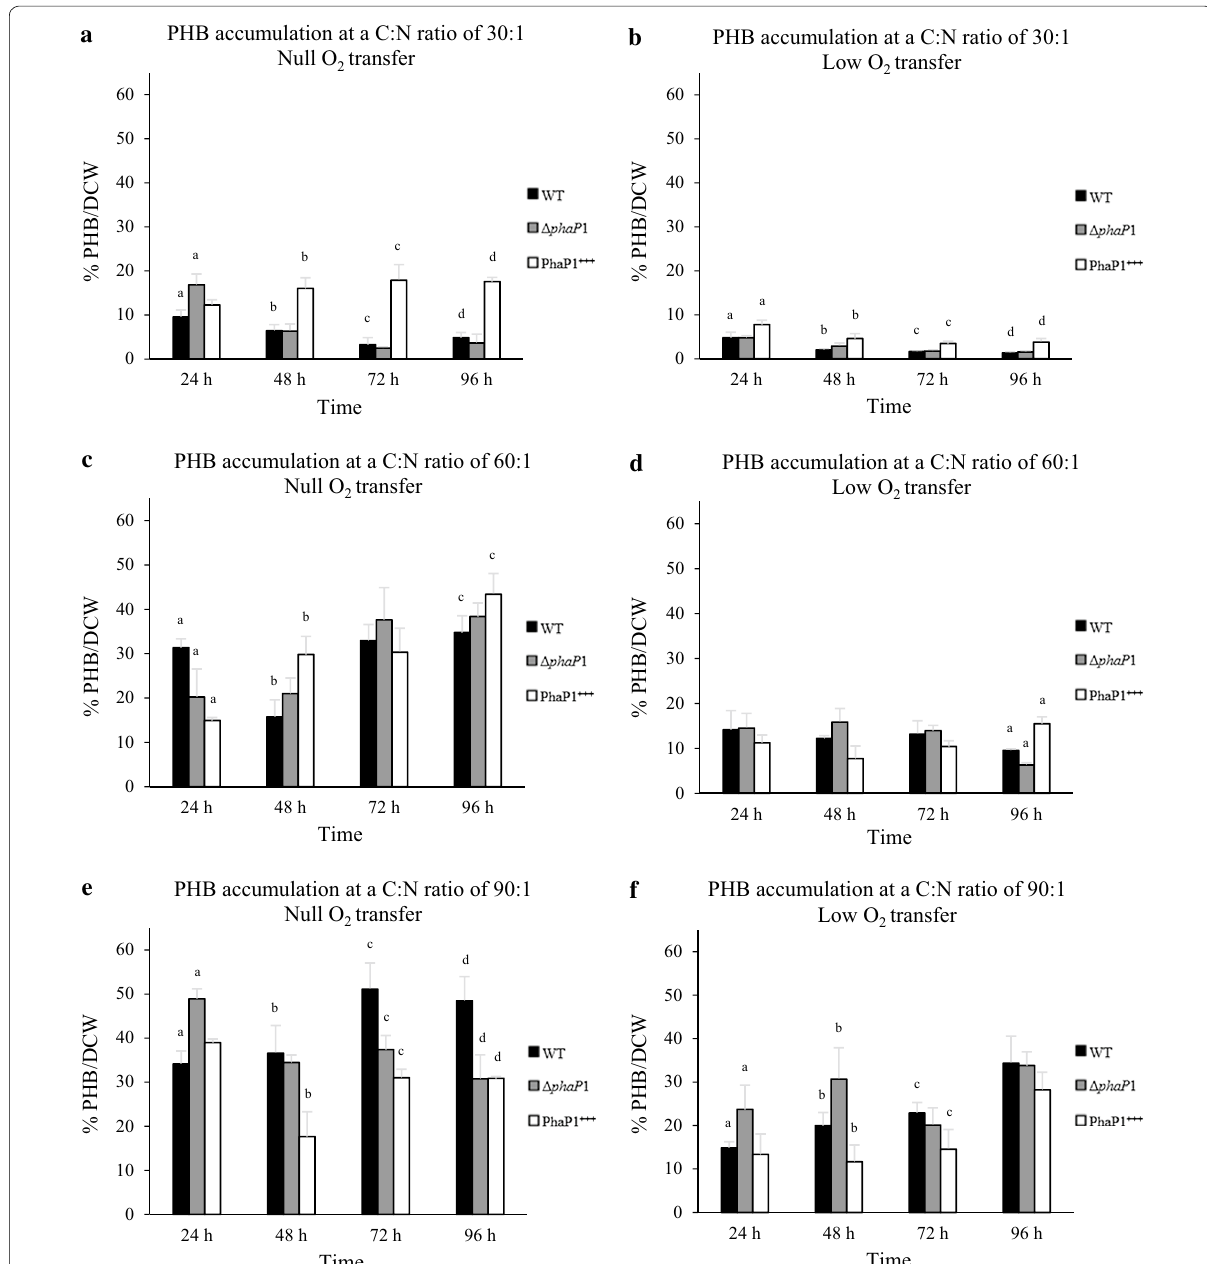
Fig. 5 PHB/DCW content in A. brasilense strains. For PHB quantitation, flasks containing minimal medium supplemented with malic acid and ammonium chloride at C:N ratios of 30:1 ( a and b ), 60:1 ( c and d ), and 90:1 ( e and f ) were inoculated with the A. brasilense strains in flasks subjected to null ( a , c and e ) or low ( b , d and f ) oxygen transfer. Samples of cultures of A. brasilense were taken every 24 h for 96 h. Cells were harvested and dried, then PHB was extracted and quantified. PHB produced by A. brasilense Sp7 (WT), A. brasilense Δ phaP1 (Δ phaP1 ) and A. brasilense PhaP1 +++ (PhaP1 +++ ) are shown. Data are presented as mean standard deviation of three independent experiments. Letters in each graphic denote ± significant differences (p > 0.05) according to a one‑way ANOVA